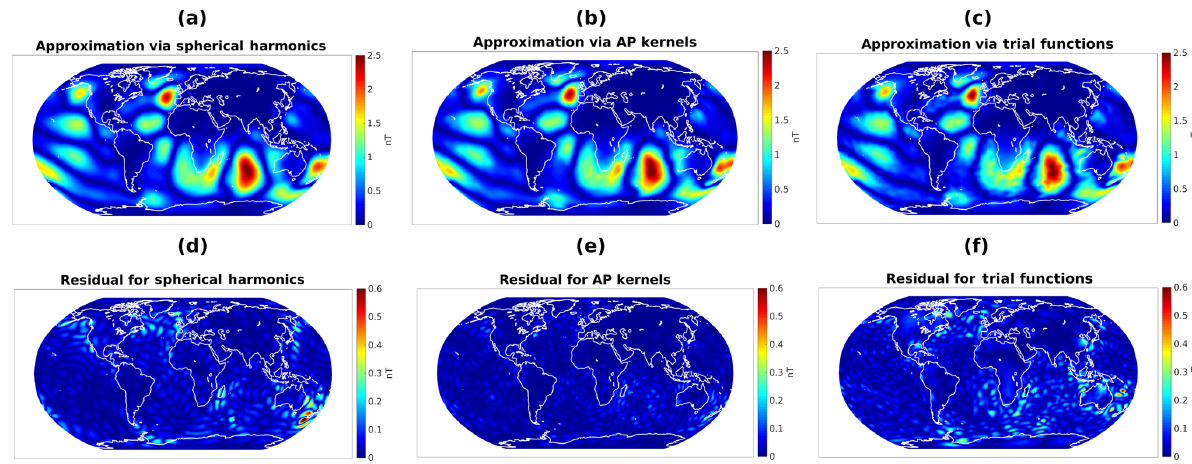
Figure 7. Absolute value of the radial part of approximations of B X3DG oc based on dictionary D 1 (a) , dictionary D 2 (b) , and dictionary D 3 (c) , as well as the corresponding residuals with respect to B X3DG oc (d, e, f) .